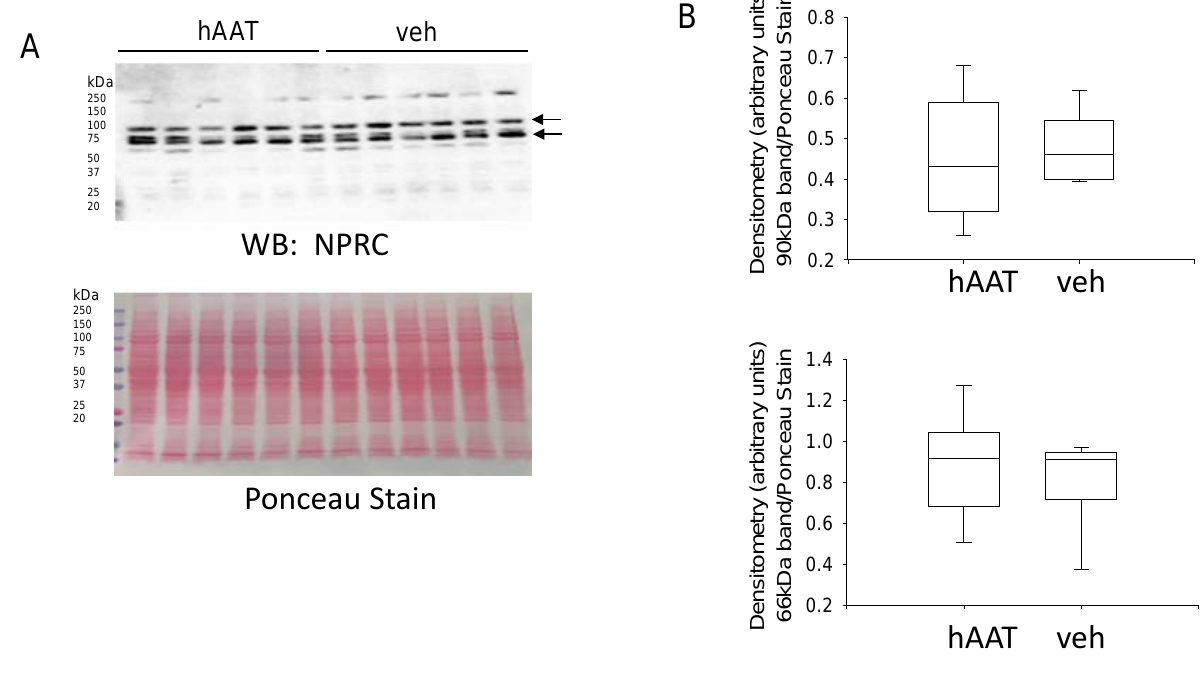
Figure 8. Western blot and densitometric analysis of NPRC protein expression after hAAT or vehicle treatment. ( A ). Western blot for NPRC protein expression. Eighty micrograms of total protein from kidney cortex lysates from hypertensive diabetic db/db mice treated with either hAAT or vehicle were resolved by SDS-PAGE and then transferred to nitrocellulose membranes which were blotted for NPRC protein expression. ( B ). Image J was used to obtain densitometry values for each band which were normalized to the Ponceau staining. N = 6 mice in each